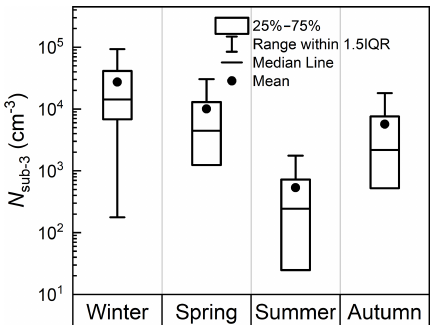
Figure 5. The seasonal variations of number concentrations of sub- 3nm aerosols ( N sub-3 ) on NPF days in urban Beijing. Data during 09:00–14:00 were shown in this figure. The vertical lines and cir- cles in the box indicate the median and mean values, respectively. The top and bottom edges represent 75th and 25th percentiles, re- spectively. The IQR is the interquartile